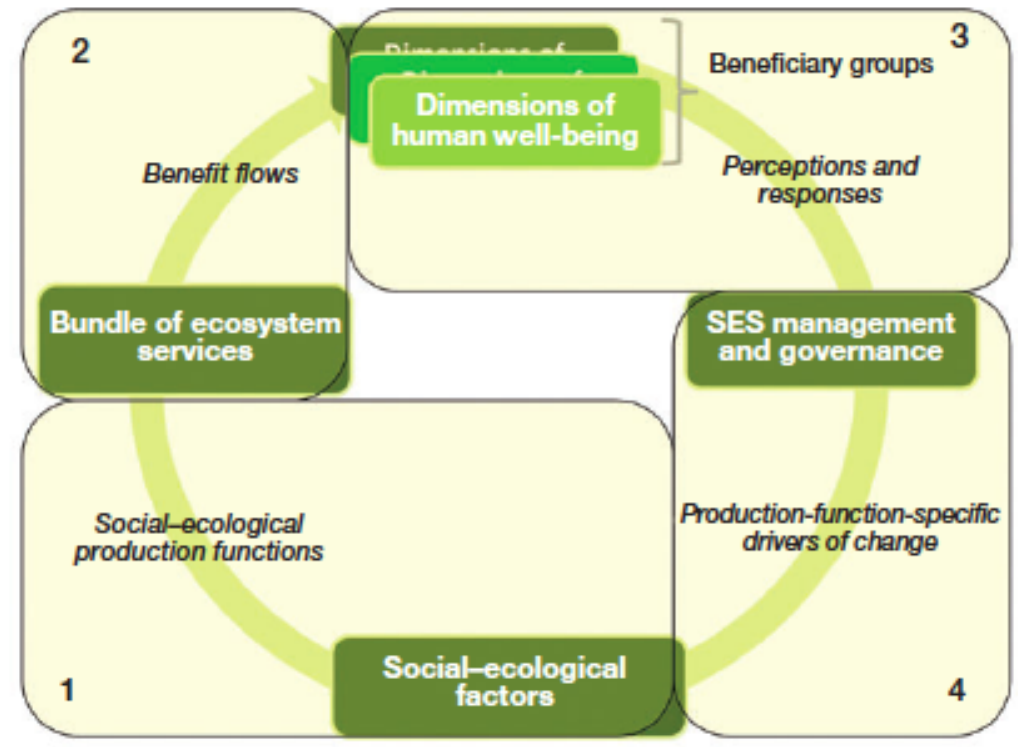
Figure 3. A social-ecological framework for ecosystem service and human wellbeing. SES, social-ecological systems. Reprinted with permission from Reyers et al. 26 (2013).